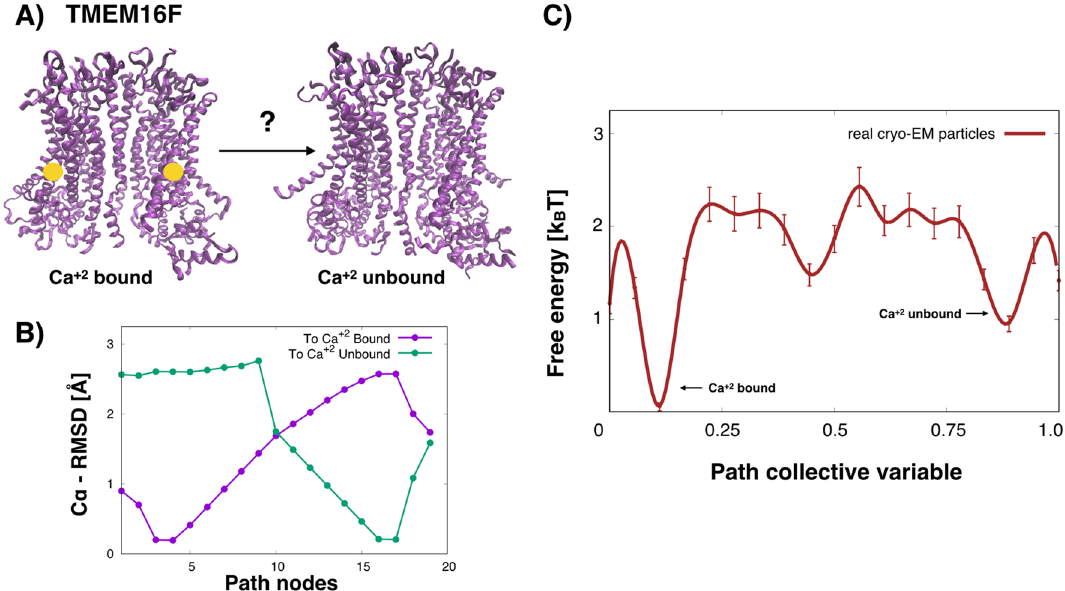
Figure 6. Real cryo-EM data for studying the TMEM16F Ca + 2 —bound/unbound transition with cryo-BIFE. ( A ) Ca + 2 -bound to the Ca + 2 -unbound states of TMEM16F (with PDB codes 6p46 and 6p47, respectively). ( B ) C α RMSD of the nodes along the path to the Ca + 2 -bound and Ca + 2 -unbound states (purple and green, respectively). ( C ) Free-energy profile extracted along the path CV from real cryo-EM particles from the dataset used to generate the Ca + 2 -bound reconstruction in digitonin 44 (EMPIAR code 10278). The R-hat test for the MCMC yielded 1.001. The bars show the credible interval at 5% and 95% of the empirical quantile at each node. Arrows point to the free-energy basins corresponding to the Ca + 2 -bound/unbound